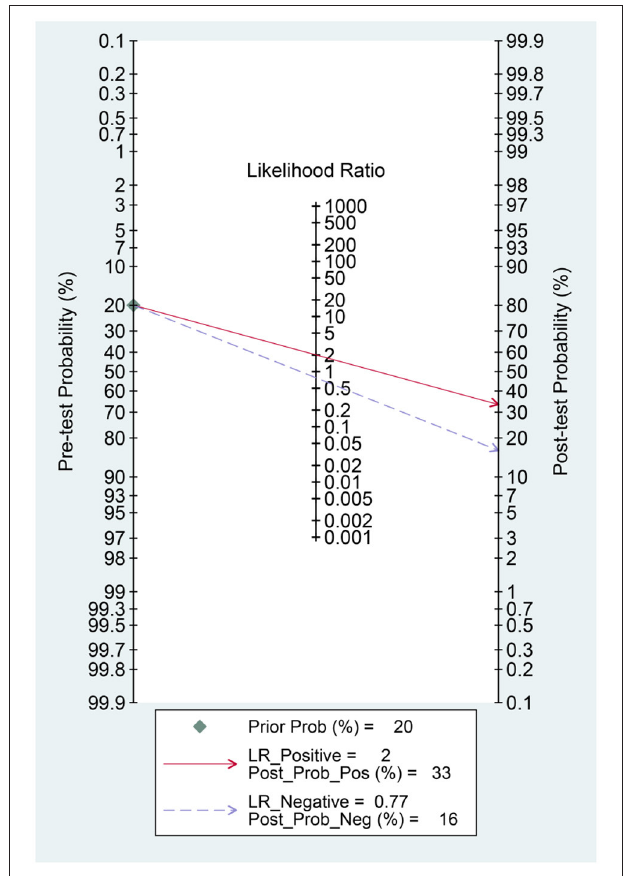
FIGURE 5 | Fagan’s nomogram.